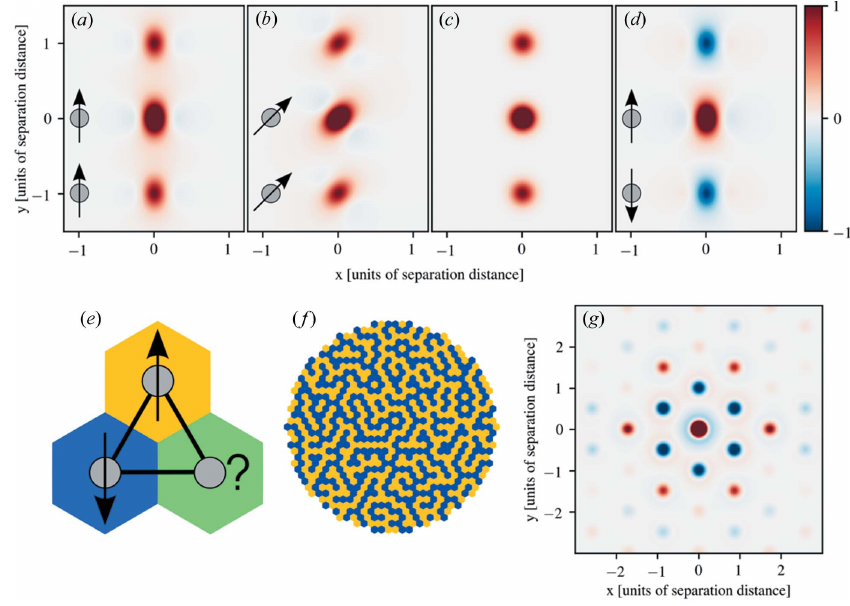
Figure 1 Simulations of the 3D-m (cid:2) PDF for simple systems. ( a ) Ferromagnetic alignment along the separating axis. A positive peak is always present at the origin as all magnetization density is aligned with itself. Positive peaks are also found at the separation vector, showing moments are aligned in same direction. ( b ) Ferromagnetic alignment tilted with respect to the separating axis. The 3D-m (cid:2) PDF is smeared in the direction of the moments. ( c ) Ferromagnetic alignment symmetry averaged for cubic symmetry. ( d ) Antiferromagnetically aligned moments. Negative peaks are found at the separation vector showing the opposite directions. ( e ) Antiferromagnetically coupled spins on a triangle. ( f ) A disordered ground state of the antiferromagnetic triangular Ising net (Wannier, 1950). Moments pointing into the plane are shown as blue and moments going out of the plane are yellow. It is calculated by starting with a random distribution of spin up/down, then repeatedly selecting a random spin and flipping it if it has more neighbors of the same type than opposite. ( g ) The 3D-m (cid:2) PDF for the antiferromagnetic triangular Ising